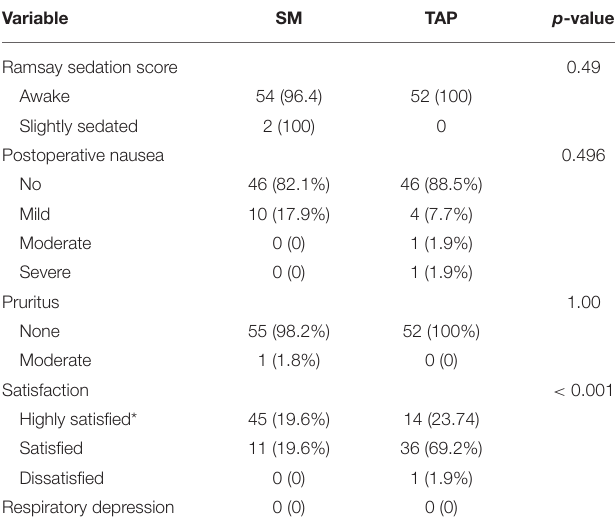
TABLE 3 | Postoperative complication and satisfaction of parturients underwent elective cesarean section under spinal anesthesia and randomized to receive spinal morphine or TAP block for postoperative pain